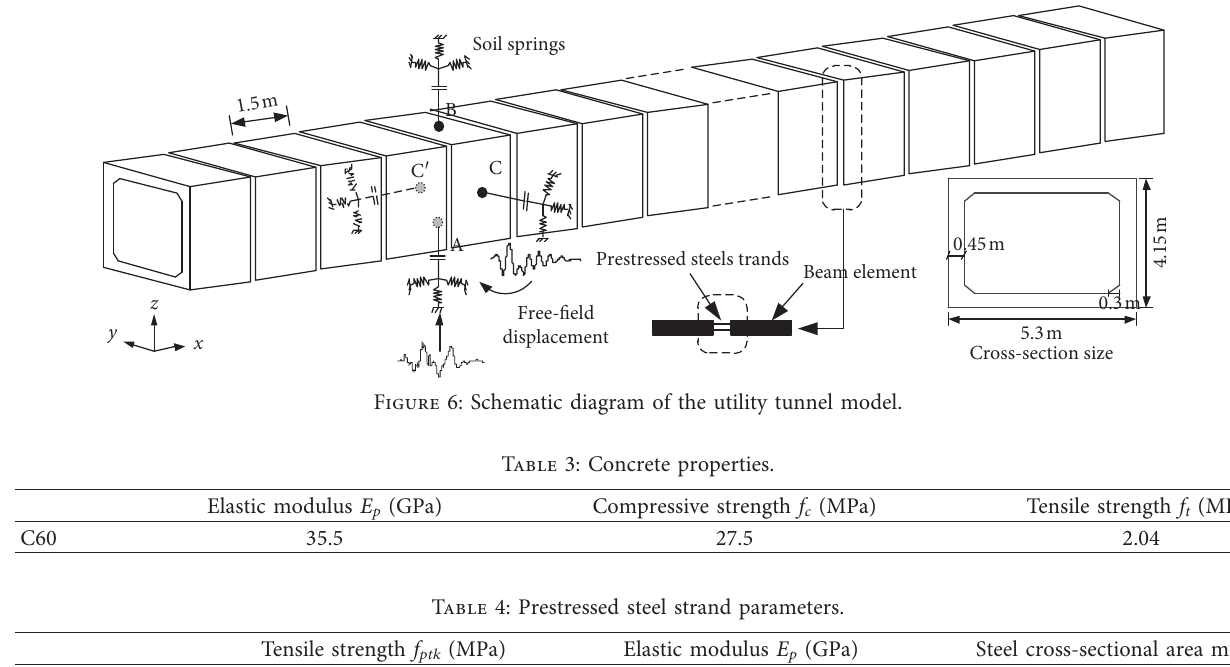
c and λ - c curves of soils. max -